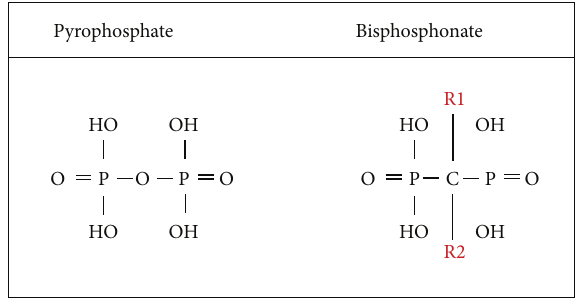
Figure 1: Chemical structure of pyrophosphate and bisphospho- nate. R1 and R2 signify the side chains of